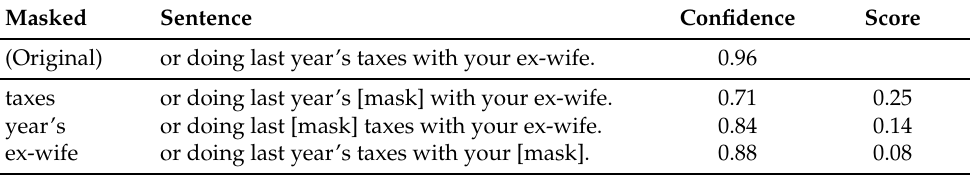
Table 2. Example of classic word importance ranking. The target model is CNN trained with SST-2. Masked Sentence Confidence Score (Original) or doing last year’s taxes with your ex-wife. 0.96 taxes or doing last year’s [mask] with your ex-wife. 0.71 0.25 year’s or doing last [mask] taxes with your ex-wife. 0.84 0.14 ex-wife or doing last year’s taxes with your [mask]. 0.88 0.08